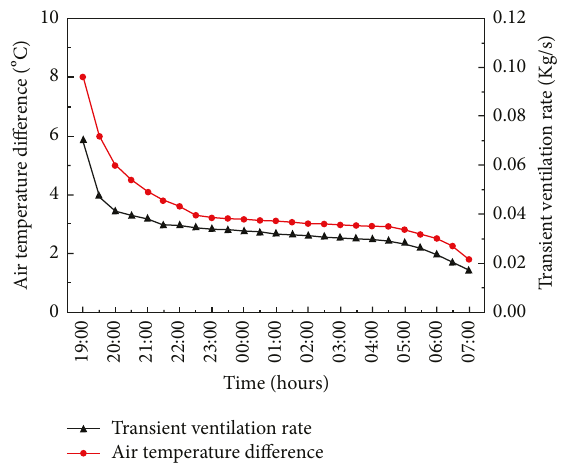
Figure 5: Variation of air temperature and ventilation rate for phase change temperature of 38 ° C.